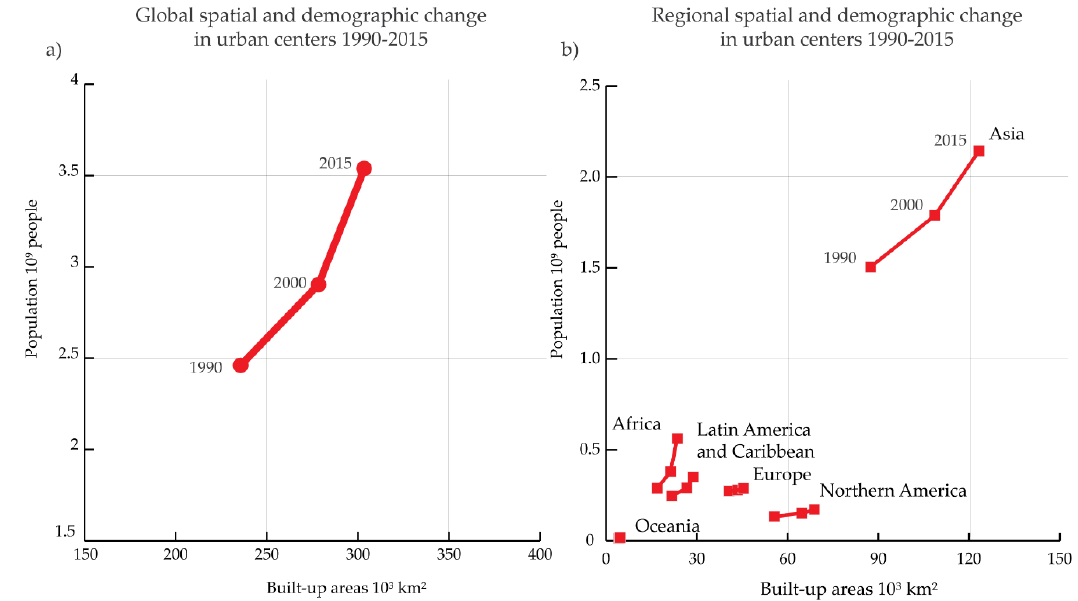
Figure 2. Multi-temporal global ( a ) and regional ( b ) extent of built-up areas and population in urban centers at corresponding epochs as estimated from GHSL data (GHS-POP and